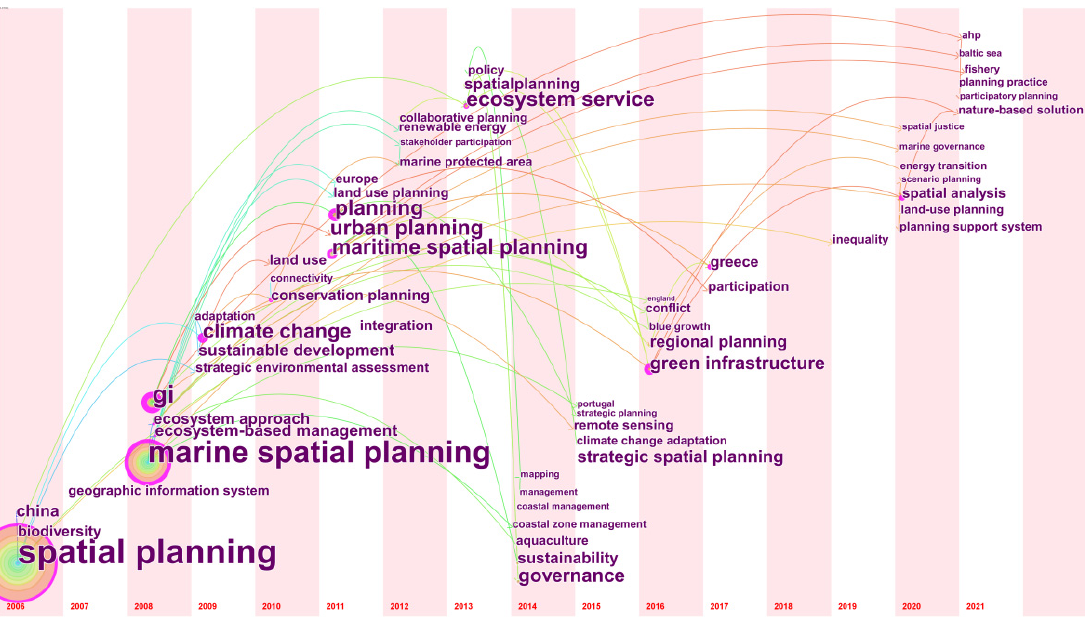
( b ) Figure 9. Visualization of keywords ( a ) and cluster analysis ( b ) (WOSCC).